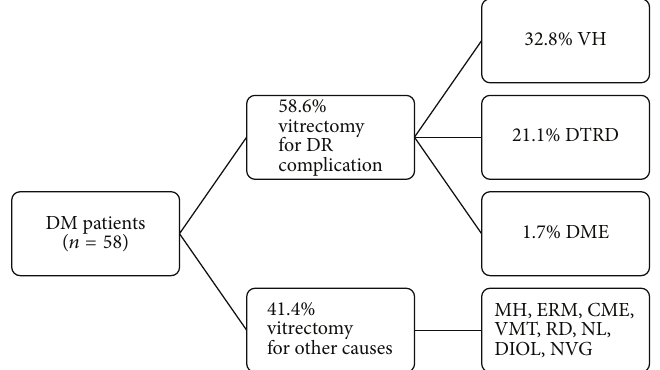
Figure 1: Underlying conditions for requiring a vitrectomy in diabetic patients. DM: diabetes mellitus; PPV: pars plana vitrectomy; DR: diabetic retinopathy; VH: vitreous hemorrhage; DTRD: diabetic tractional retinal detachment; DME: diabetic macular edema; MH: macular hole; ERM: epiretinal membrane; CME: cystoid macular edema; VMT: vitreomacular traction; RD: retinal detachment; NL: nucleus loss; DIOL: dislocated intraocular lens; NVG: neovascular glaucoma. Table 1: Baseline characteristics and postoperative